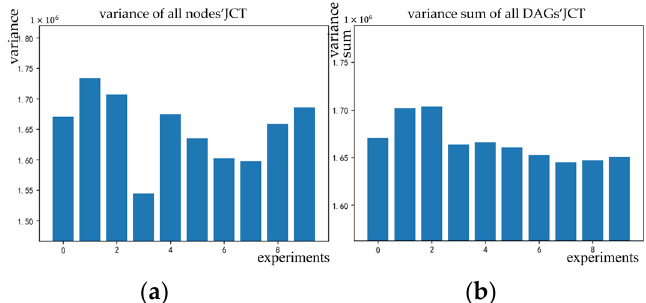
Figure 7. The variance in JCT in Tpc-h.